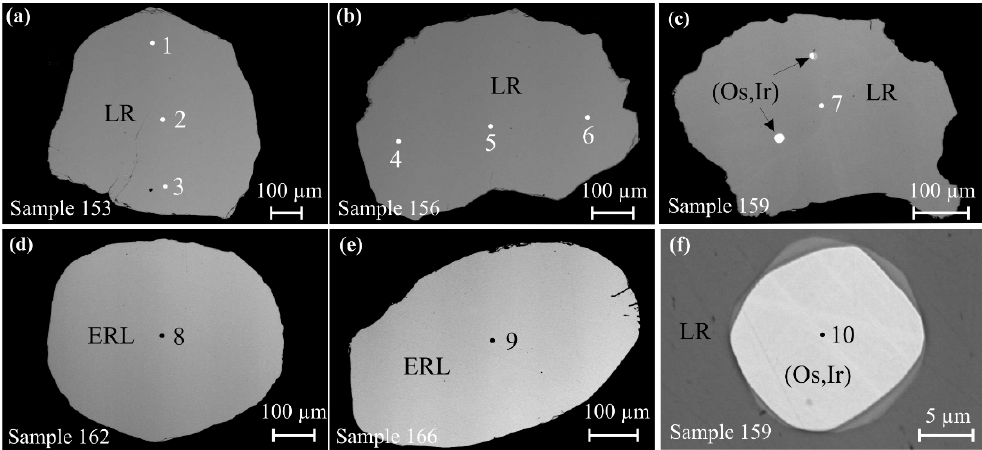
Figure 3. Back-scattered images of laurite grains of type 1 at Verkh-Neivinsk: ( a )—sample 153, ( b )—sample 156, ( c )—sample 159, ( d )—sample 162, ( e )—sample 166, ( f )—detail of Figure 2c. LR—laurite, ERL—erlichmanite, (Os,Ir)—iridian osmium. Numbers 1–10 denote areas of electron microprobe analyses corresponding to the same numbers in Tables 1 and 2.